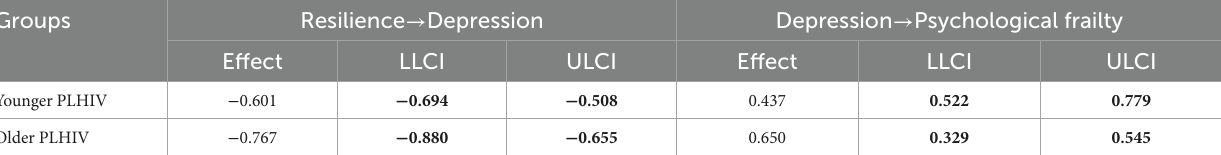
TABLE 6 Results of the moderating effect of age in the indirect effects of resilience on psychological frailty.